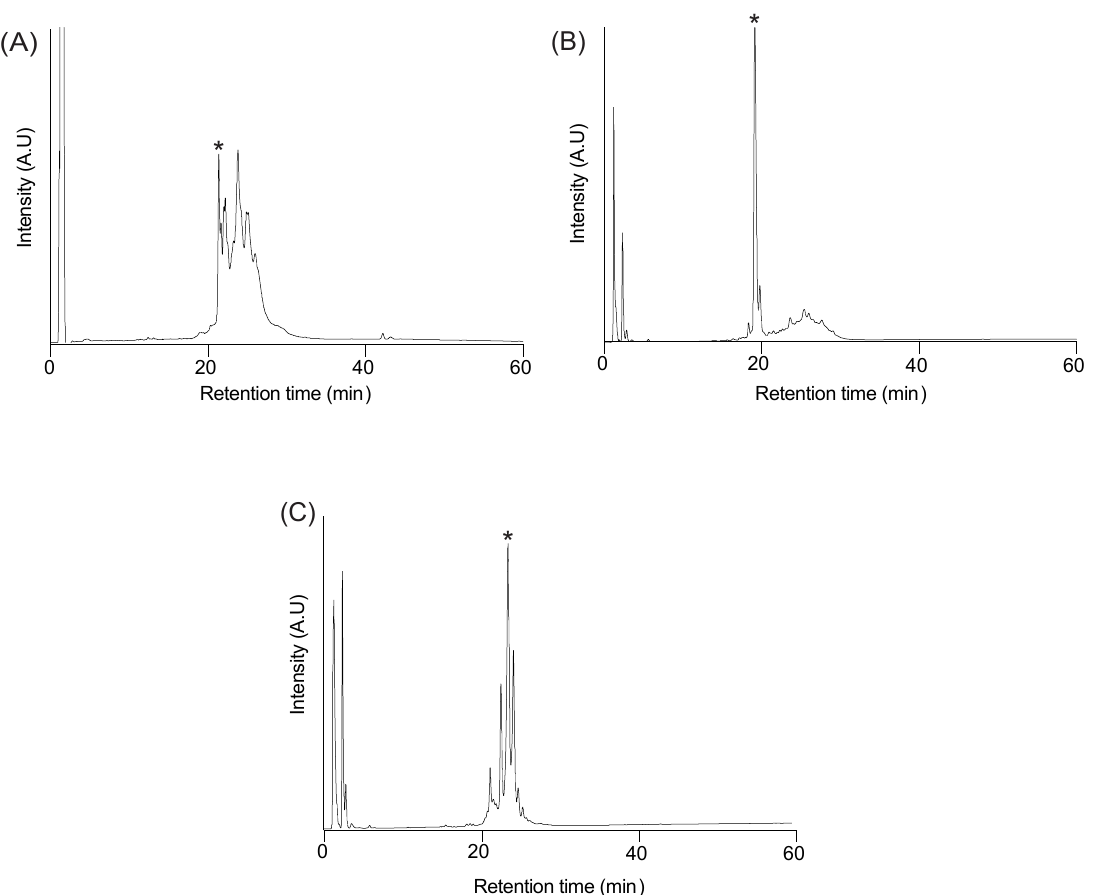
Figure 2. RP-HPLC analysis of the oxidation reaction of granulin N-terminal truncated analogues ( A ) ZF-N 24_3s , ( B ) ZF-para _3s and ( C ) ZF-N 24_2s . Analytical RP-HPLC was carried out using a Phenomenex Jupiter 4 μm Proteo column (C 12 , 150 × 2.00 mm, 10 μm, 90 Å) using a gradient of 0–60% solvent Β